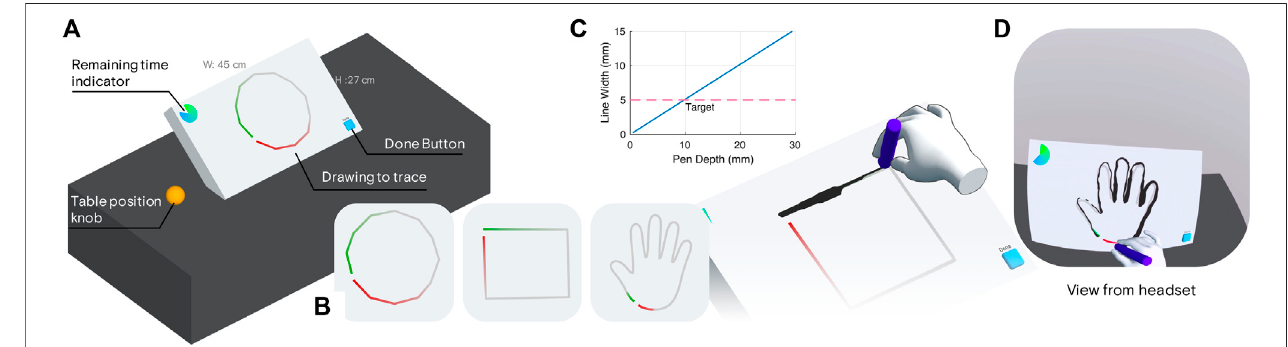
FIGURE8| Anoverview oftheuser studyenvironment: (A) Anadjustable fl oating desk ispresented tothe useralongwithacanvas. Thecanvascontainstemplate for the user to trace with along with an indicator for the remaining time in each repetition. The canvas can also present buttons for the user to indicate that they ’ re done with the drawing or answers to questions. (B) Three shapes are used in the user study: a circle, a square and an outline of a hand. Participants start tracing at the green line section and end at the red line section. (C) A plot of the line width that results from how deep the users actual hand is penetrating the surface of the canvas.